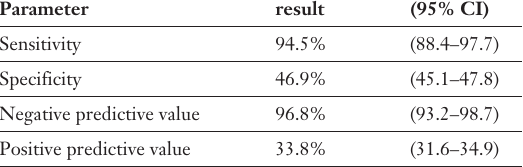
D-dimers ELISA assay performance in the study